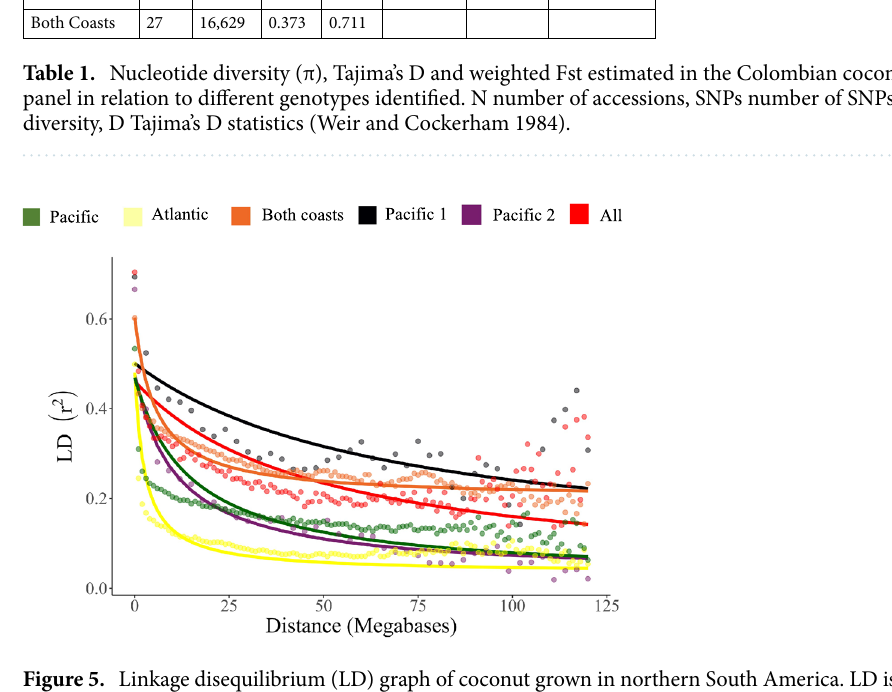
Figure 5. Linkage disequilibrium (LD) graph of coconut grown in northern South America. LD is determined by squared correlations of allele frequencies (r 2 < 0.3) against distance between polymorphic